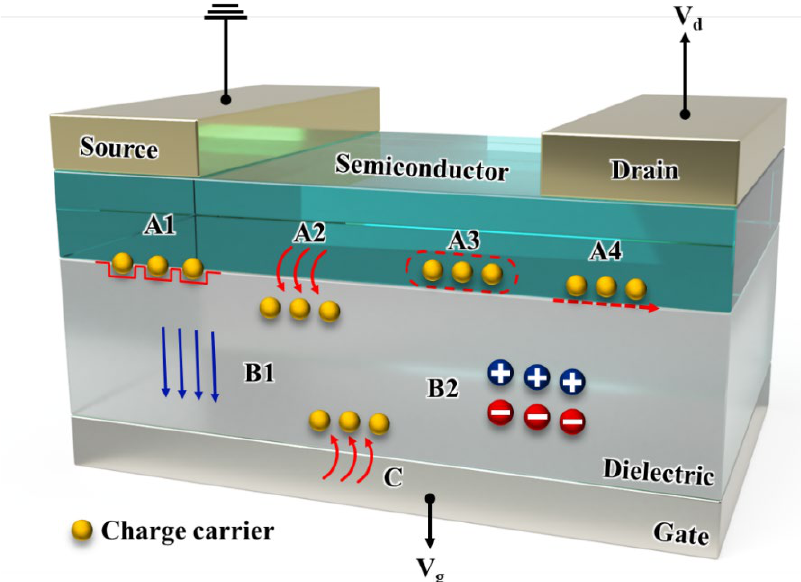
Figure 5. Scheme of mechanisms that cause hysteresis with BGTC structure.